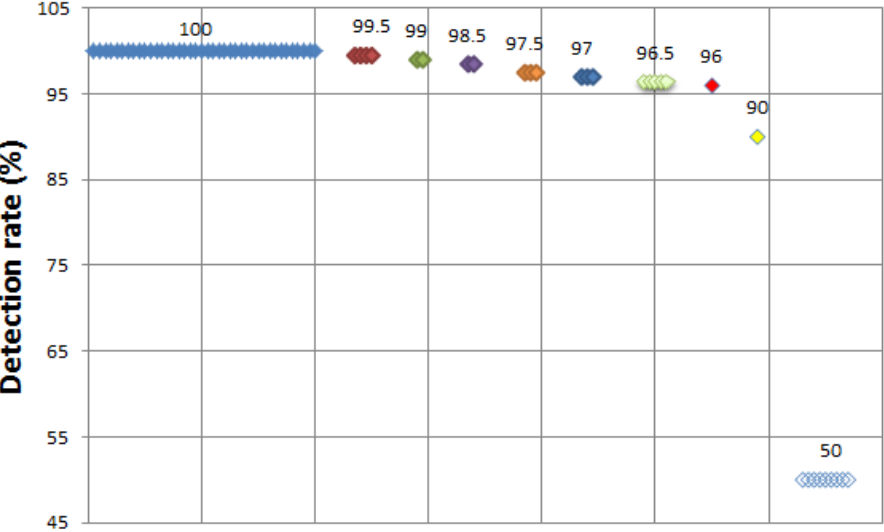
Figure 9. Buffer overflow attack—detection rate (all).